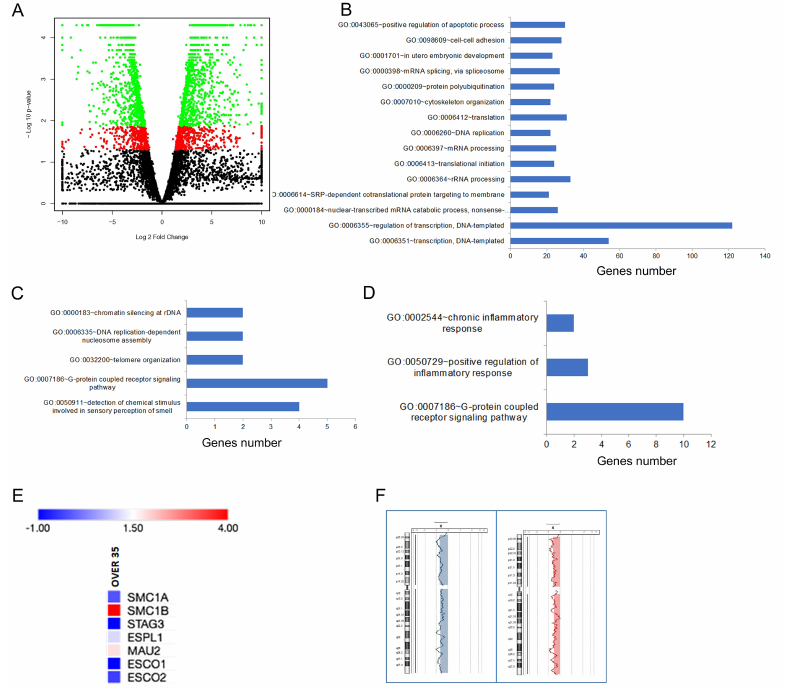
Figure 1. Gene expression profiles of single human oocytes. ( A ) A total of 1852 genes were di ff erentially expressed in age group < 35 vs. ≥ 35 years. Volcano plot of gene expression changes in oocytes < 35 vs. ≥ 35 years. The x -axis displays the log2 fold change value and the y -axis corresponds to the negative logarithm to the base 10 of the t -test p -values. The black dots correspond to genes with no significant di ff erence, the red dots represent dysregulated genes with a range of values with p < 0.05 and the green dots are significant with p < 0.05 (adjusted p -values). ( B ) GO term enrichment analysis of biological processes that were significantly over-represented when considering DEGS in oocytes < 35 vs. ≥ 35 years. In particular, pathways related to gene transcription, apoptosis, cytoskeleton organization and to mRNA maturation and translation were over-represented. ( C ) GO term enrichment analysis of biological processes that were significantly over-represented in genes expressed exclusively in oocytes < 35 years. ( D ) GO term enrichment analysis showed that the “G-protein coupled receptor signalling pathway” (GO:0007186) was significantly over-represented in genes expressed exclusively in oocytes ≥ 35 years. ( E ) Heat map of cohesin genes di ff erentially expressed when oocytes < 35 vs. ≥ 35 years were compared. Their fold change ranges from − 1 to + 4. The expression of SMC1B and MAU2 increased whereas ESCO1 , ESCO2, ESPL1 , SMC1A and STAG3 genes decreased in the ≥ 35 years age group. ( F ) Array comparative genomic hybridization analysis in 20 oocytes from women ranging from 19 to 42 years old. We identified the loss of the X chromosome in two subjects belonging to the ≥ 35 years age